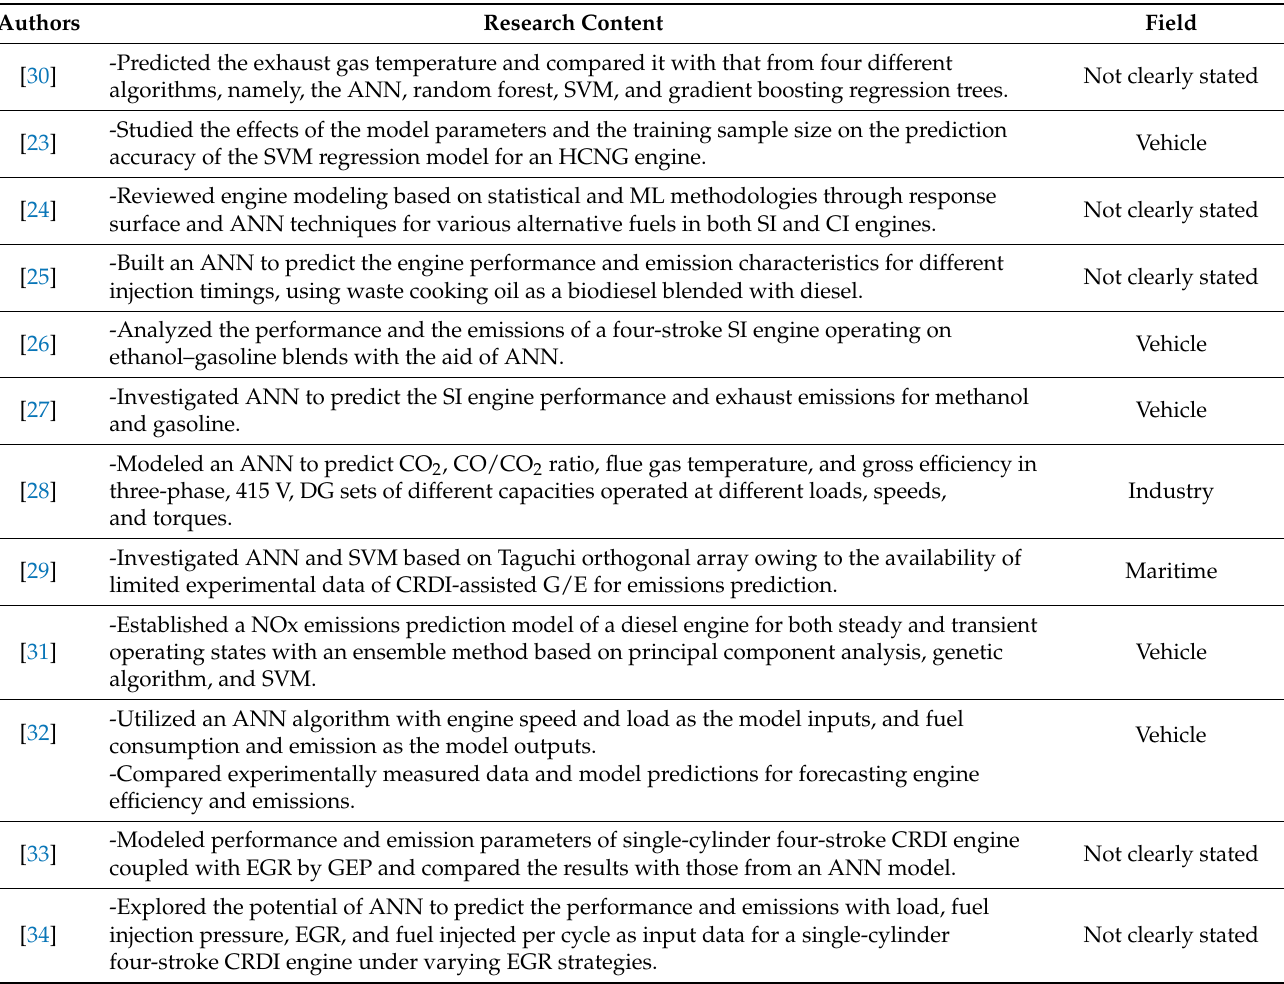
Table 1. Reviewed articles related to engine exhaust emissions using